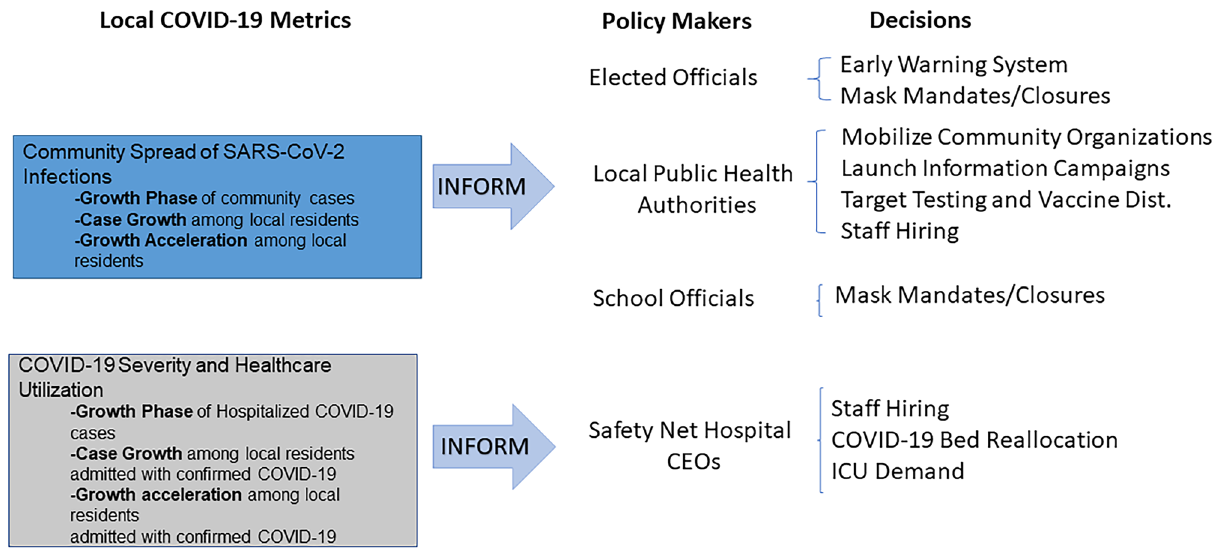
Figure 5. Community metrics informing response to COVID-19